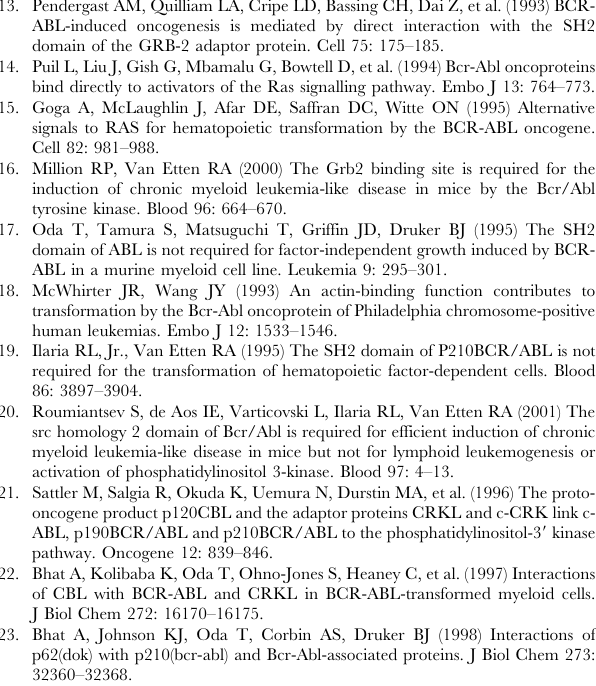
Table S1 Relative percentage of GFP positive cells in bone marrow used for transplantation. Flow cytometric analysis of the percentage of GFP positive bone marrow cells post infection with the indicated retroviral supernatants used in the bone marrow transplantation/ transduction